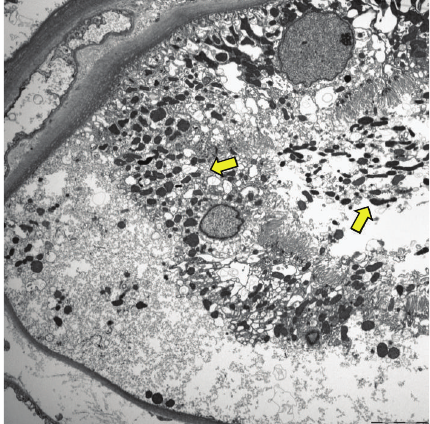
Figure 2: Ultrastructural examination reveals subendothelial electron-densematerials(thickarrows). Focallossandfusionoffoot processes of podocytes are also noted (thin arrows) (TEM × 2500).